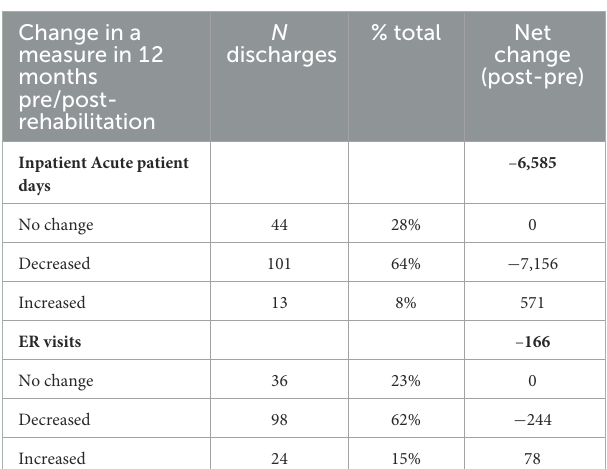
TABLE 7 Estimated cost